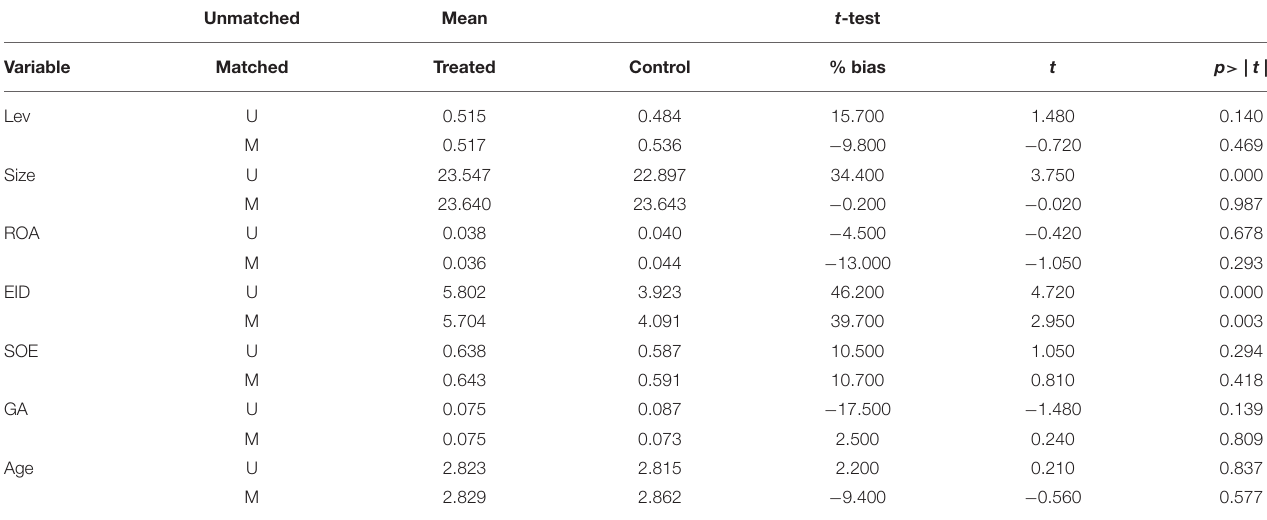
TABLE 6 | Sample balance test.